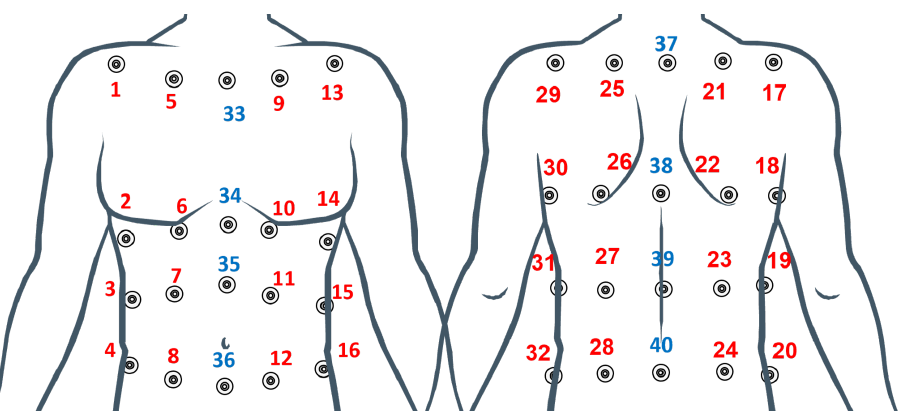
Figure 2. Marker positioning on the back and front side of the chest wall surface. The chest wall is subdivided into two main compartments: Rc and AB. Rc extends from the clavicles to the lower costal margin line of markers. AB covers the caudal parts of the frontal chest, from the lower costal margin to the level of the anterior superior iliac crest. Four posterior horizontal rows (between C7 and the posterior axillary lines) contribute to the coverage of the back. The blue markers represent the additional 8 markers to the 32 marker protocol.